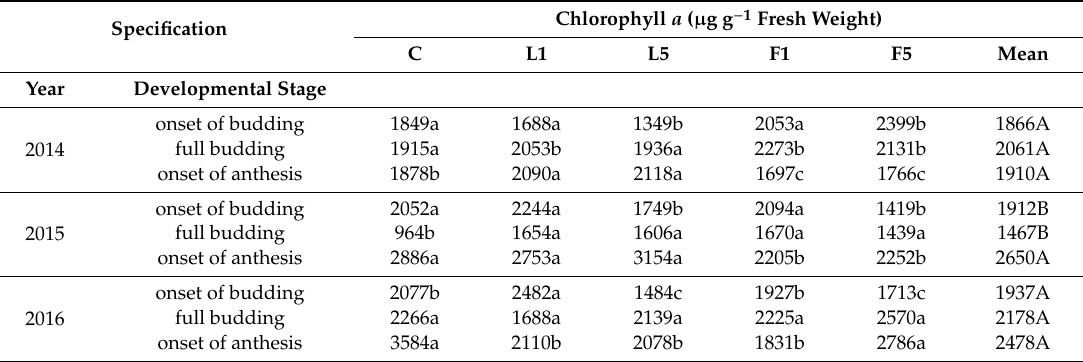
Table 4. Influence of electromagnetic stimulation on chlorophyll a